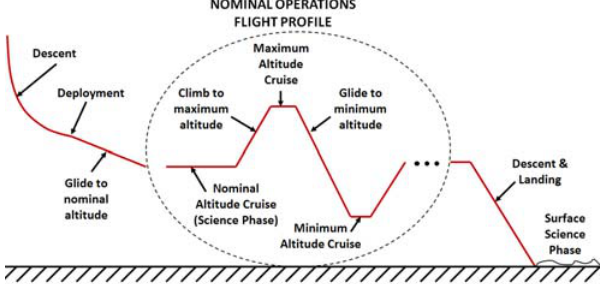
Figure 1: Atmospheric Flight on Titan Mission